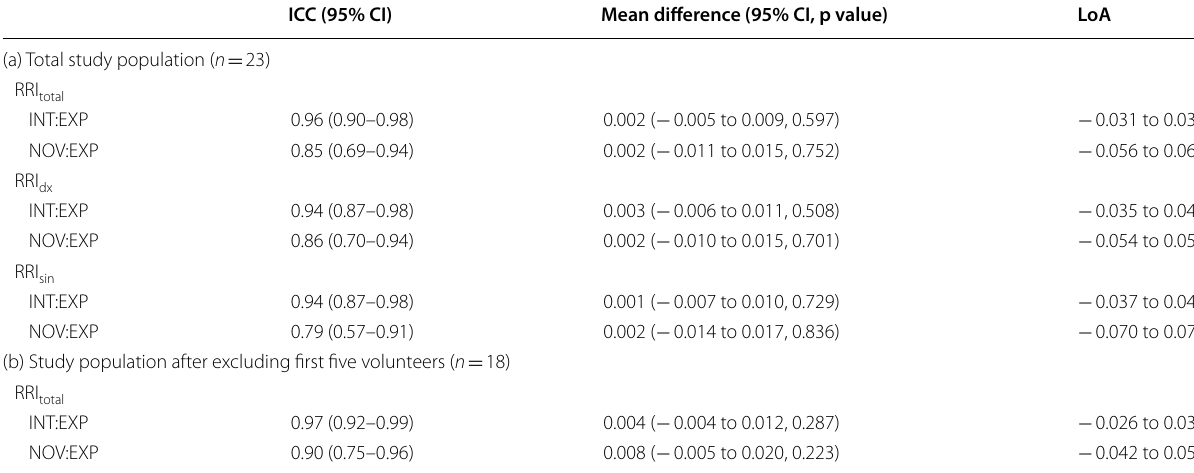
Table 2 Comparison of RRI measurements between respective non-expert and expert examiners